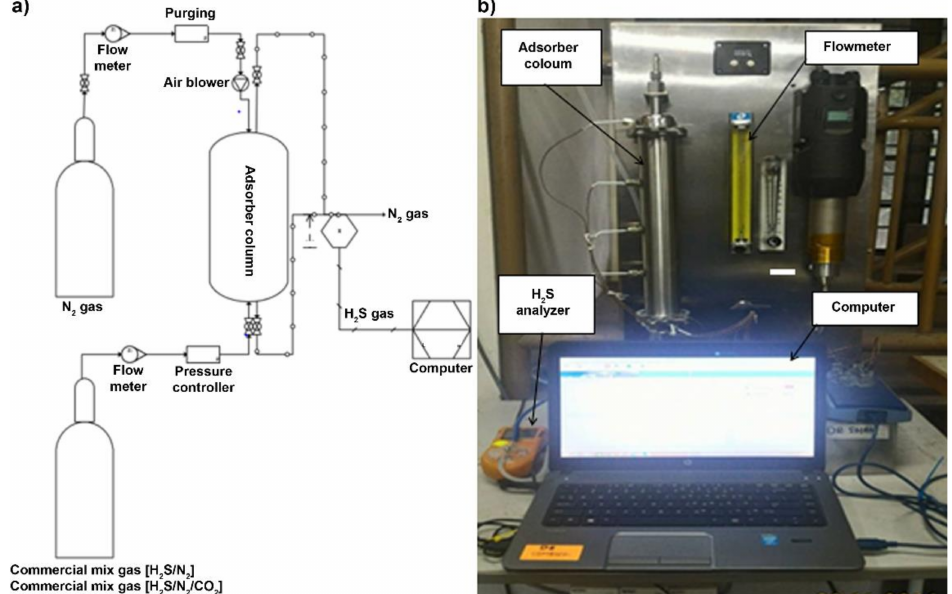
Figure 1. Adsorber column. ( a ) Schematic diagram of operating adsorber column. ( b ) Actual photo of experimental